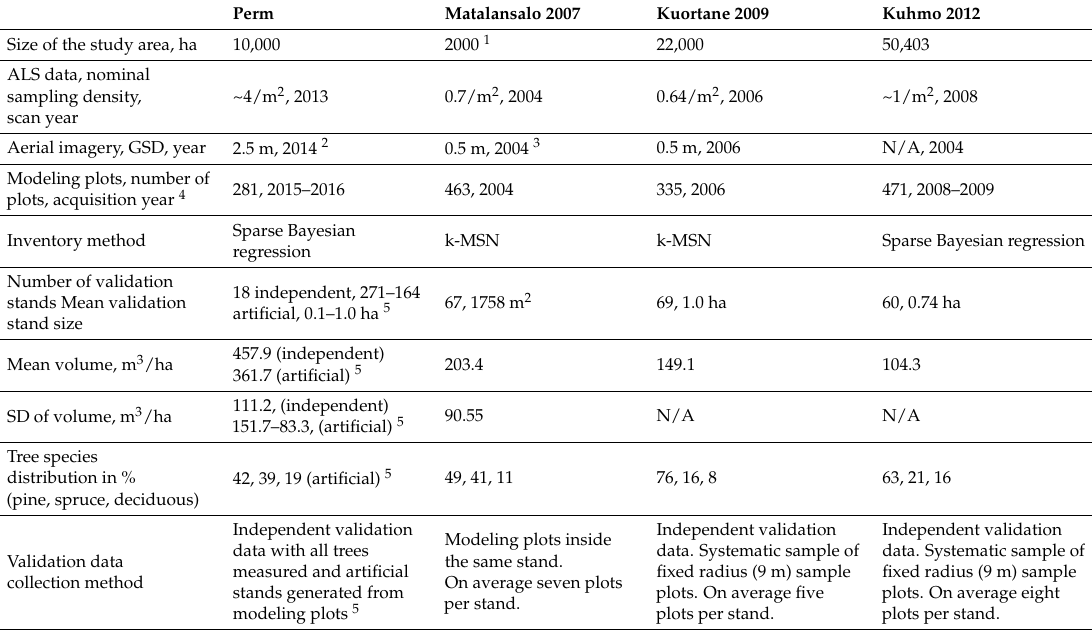
Table 2. Main characteristics of the Perm study and three Finnish